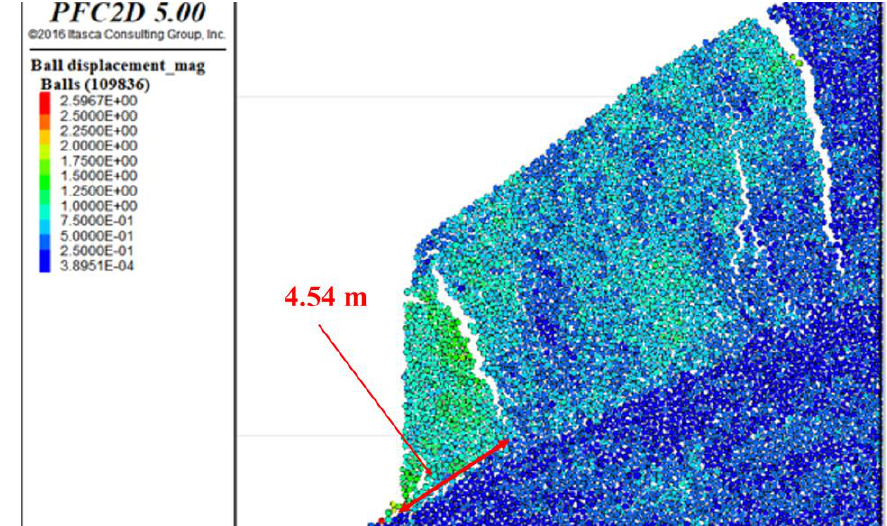
Figure 13. PFC2D rock mass displacement diagram.